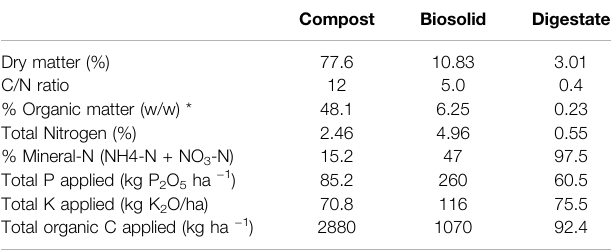
S1 ). Daily ambient